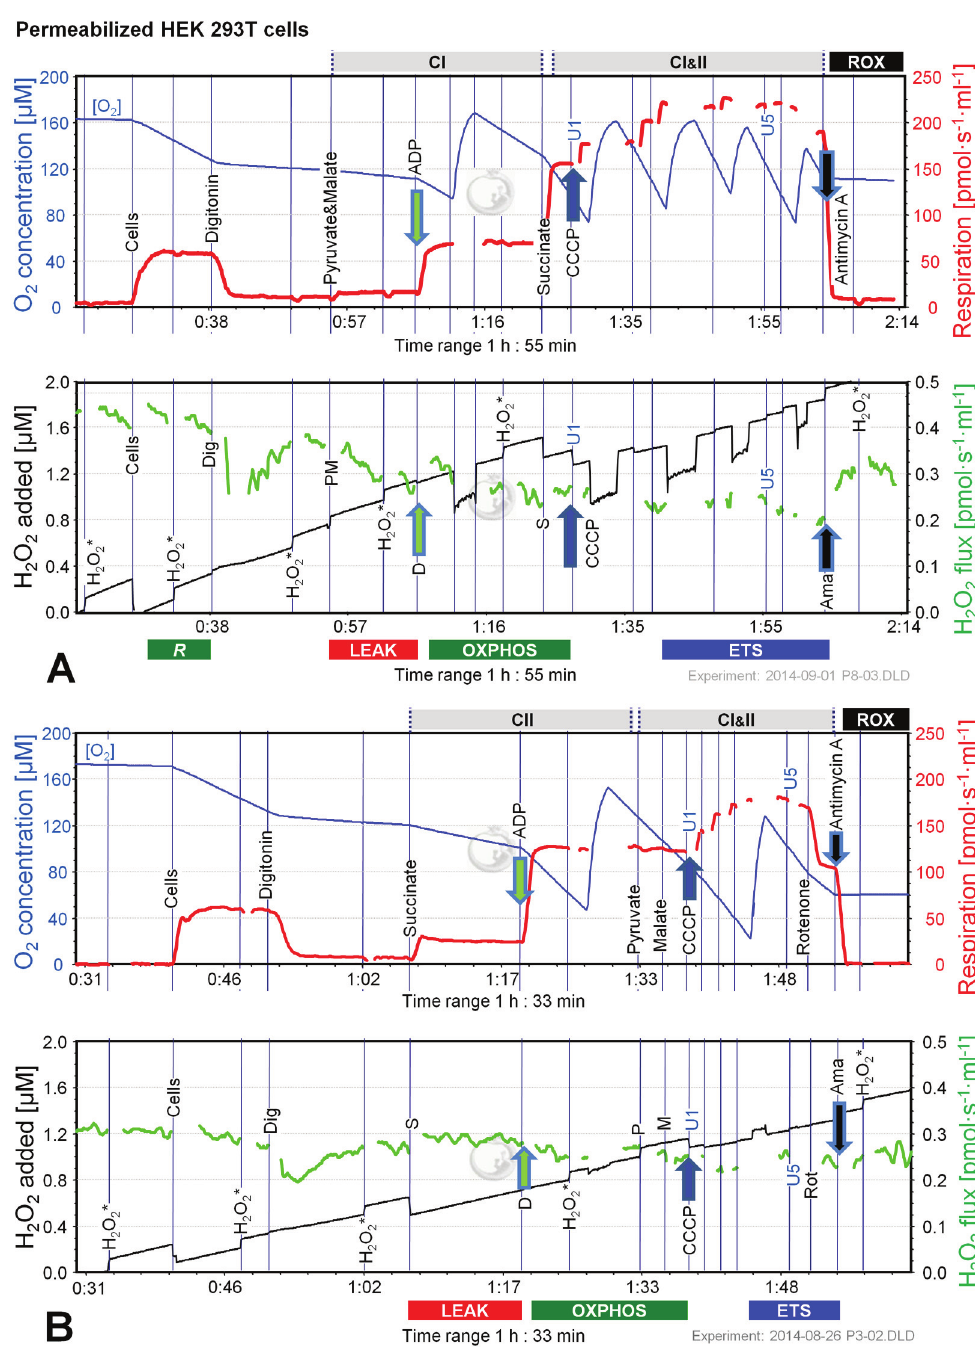
Figure 3. Combined determination of oxygen consumption and H 2 O 2 flux by O2k-Fluorometry in permeabilized HEK 293T cells. ( A ) Respiration and fluorescence changes using P and M as initial substrates; ( B ) Respiration and fluorescence changes using succinate (S) as initial substrate. Respirometric measurements are shown in the upper panels as described in Figure 1. U1 and U5 indicate final uncoupler concentrations [μM] added in 1 μM steps. In the lower panels the black plots show the fluorescence signal. H 2 O 2 * indicates titrations of 0.1 μM H 2 O 2 for calibration, to convert the fluorescence signal to an equivalent H 2 O 2 concentration (left Y -axis [μM]). Plots are shown on the basis of the first calibration with H 2 O 2 . The positive time derivative yields the volume-specific H 2 O 2 flux shown as the green plots (right Y -axis [pmol·s (cid:2)1 ·mL (cid:2)1